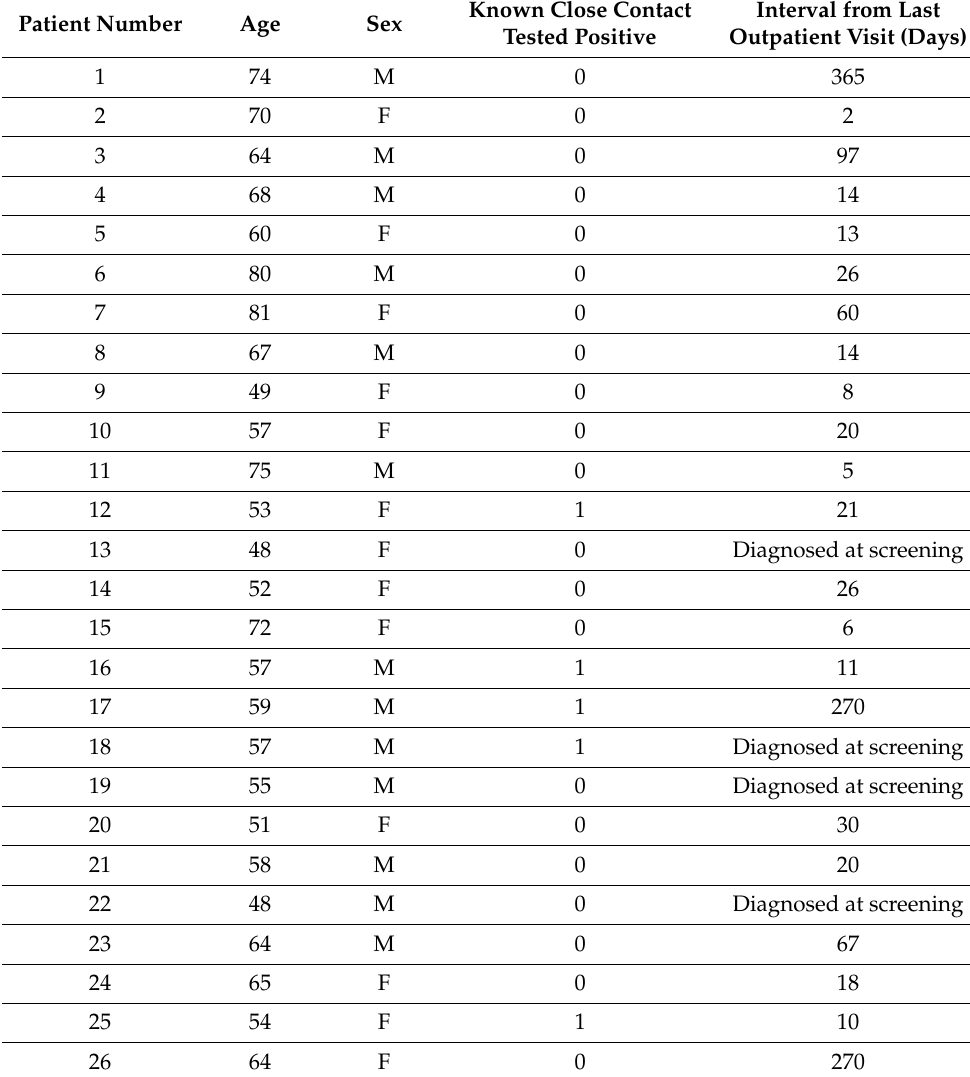
Table 2. Tracing of